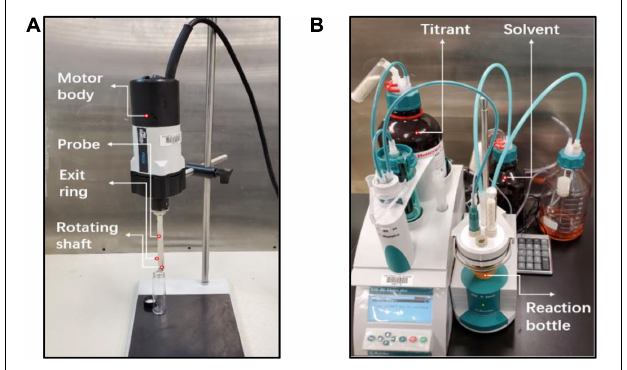
FIGURE 1 | Bottle test instruments: (A) High-shear homogenizer (B) KF auto